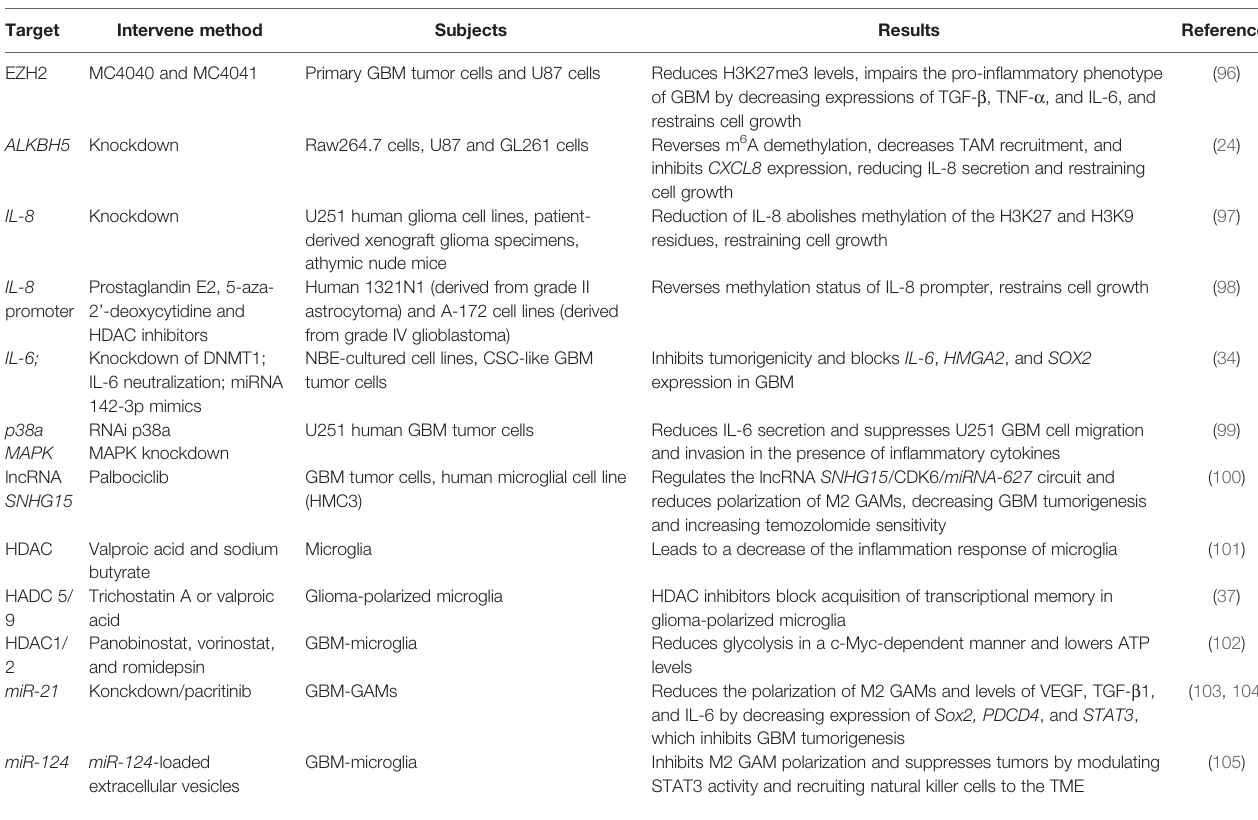
TABLE 1 | Epigenetic control in fl ammatory response of